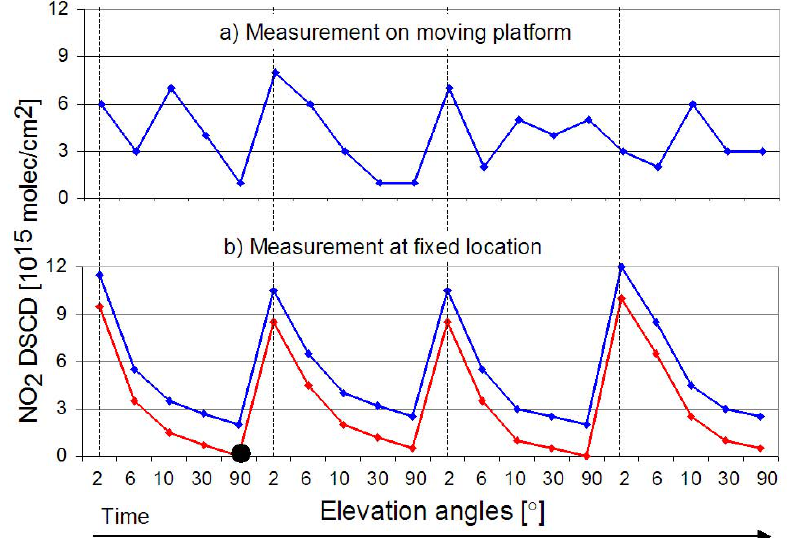
Fig. 1. Typical examples of trace gas slant column densities (DSCD meas , see Eq. 2) obtained for 4 successive elevation angle sequences (2 ◦ , 6 ◦ , 10 ◦ , 30 ◦ , 90 ◦ ). Bottom: results for MAX-DOAS observations made at a fixed location. The highest SCDs are observed for the lowest elevation angles. The red line indicates results analysed with the 90 ◦ spectrum of the first sequence as Fraunhofer reference (thus DSCD meas of the first sequence directly yield DSCD trop , see Eq. 3). The blue line indicates results analysed with a Fraunhofer spectrum from another day, and DSCD trop can be obtained using Eq. 4. Top: results for MAX-DOAS observations on mobile platforms. No clear dependence of the SCD meas on elevation angle is found, because the trace gas concentration changes with